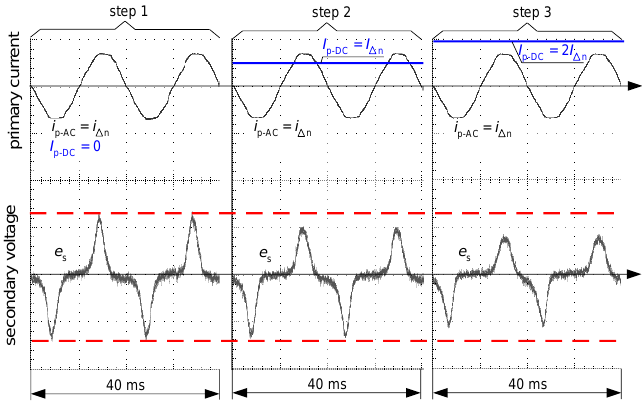
Figure 16. Oscillograms of the induced secondary voltage e s in case of the iron core of round hysteresis loop (as in Figure 15a). Primary current i p composed of sinusoidal AC waveform ( i p-AC = i ∆ n ) and DC component ( I p-DC ) of the consecutive values: I p-DC = 0 (step 1), I p-DC = I ∆ n (step 2), I p-DC = 2 I ∆ n (step 3).